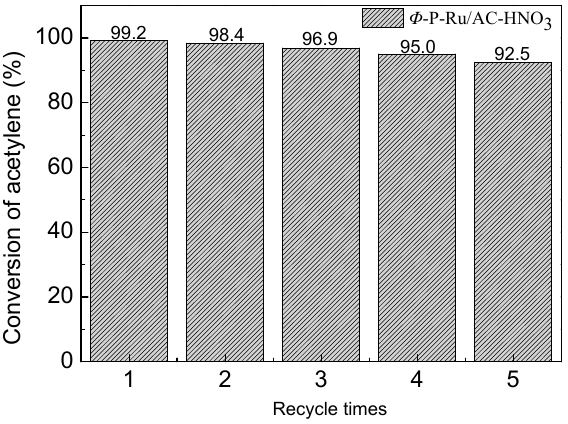
Figure 7. Catalytic performance of the recycled φ -P-Ru/AC-HNO 3 catalysts. Reaction conditions: temperature (T) = 180 °C, GHSV (C 2 H 2 ) = 180 h − 1 and V HCl /V C2H2 = 1.15.